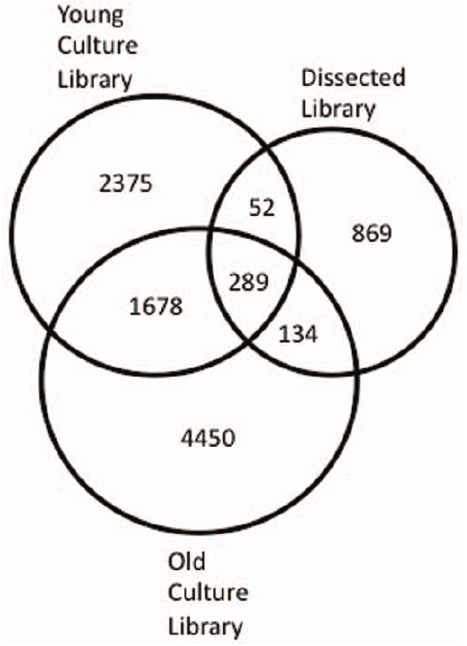
Figure 2. Venn Diagram showing numbers of overlapping sequences from each library within the total